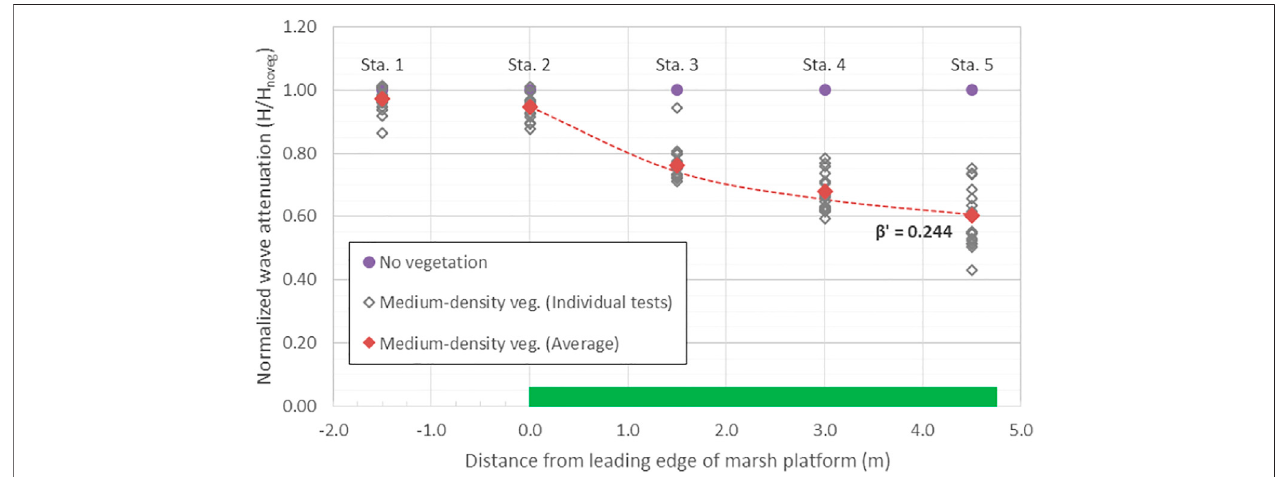
FIGURE 6 | Wave attenuation across the arti fi cial marsh for medium-density vegetation only. Data is normalized by the case with no vegetation to remove the effectsofwavetransformation and breakingdue tothe sloping foreshore and shallow depths, and highlightthe roleofvegetation in waveattenuation.Open symbols( ◇ ) show the observed attenuation across a wide range of wave heights, periods, and water depths, while fi lled symbols ( ◆ ) denotes the average with fi tted damping coef fi cient β ’ . Refer to Figure 2 for the location of the measurement stations.